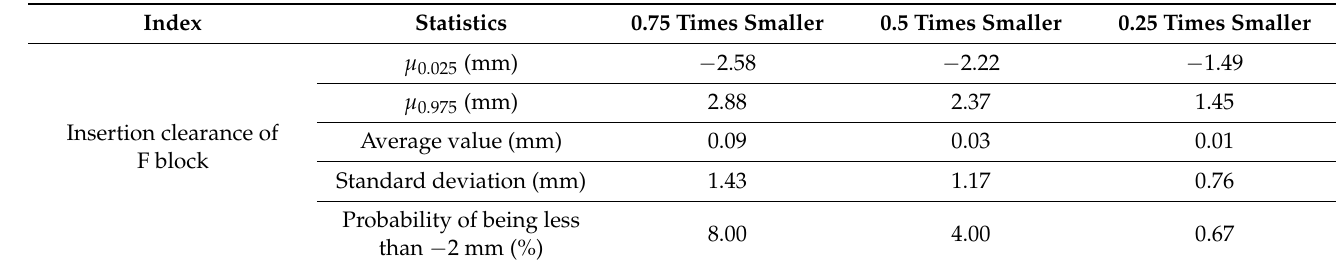
Table 10. Influence of the standard deviation of the positioning error in the rZ direction on insertion clearance of the F block.